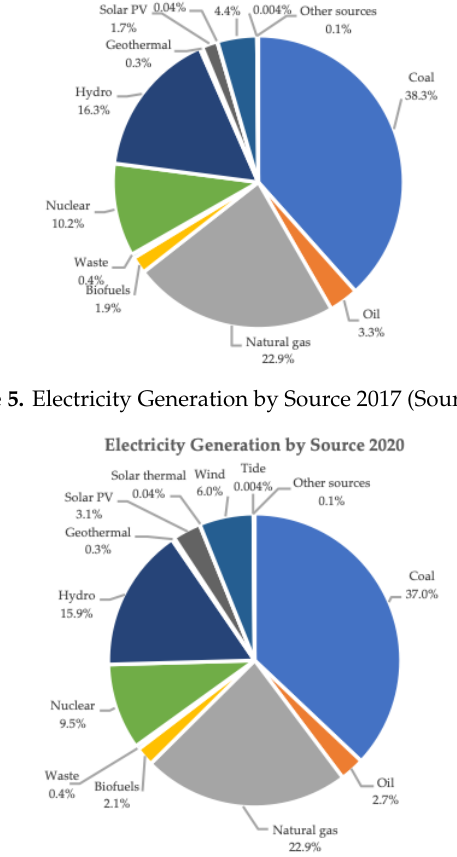
Figure 6. Electricity Generation by Source 2020 (authors’ forecasts).